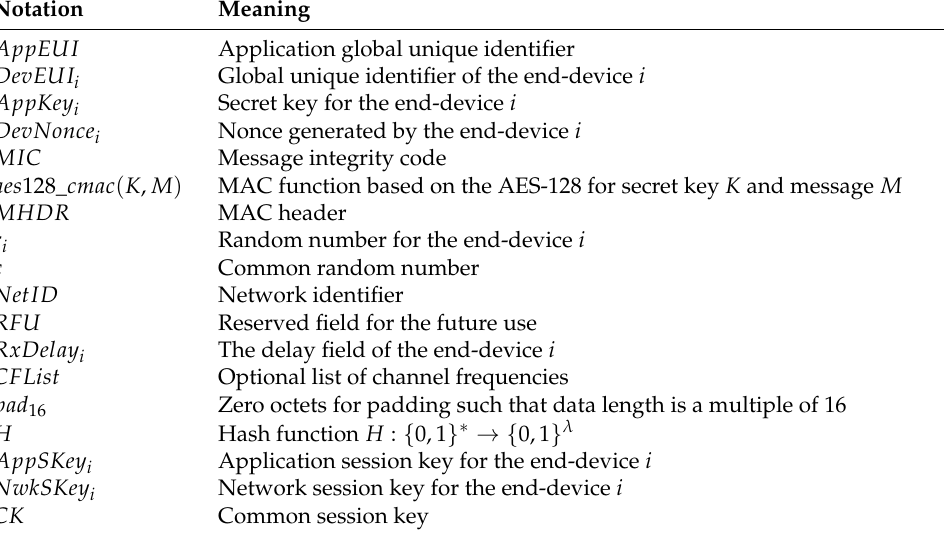
Table 1. A list of